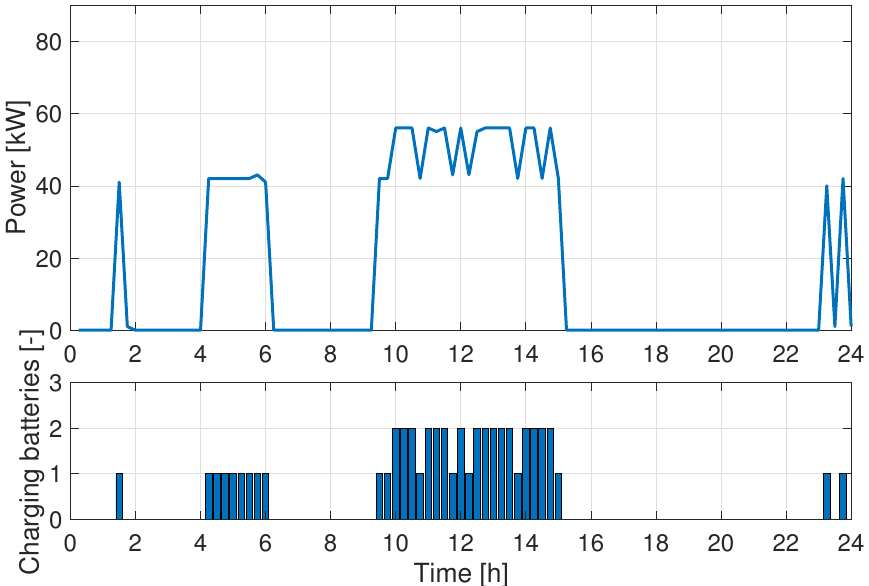
Figure 3. Power consumption (top) and battery charging schedule (bottom) at LIMB for the Most Demanding Day case (BPC only).